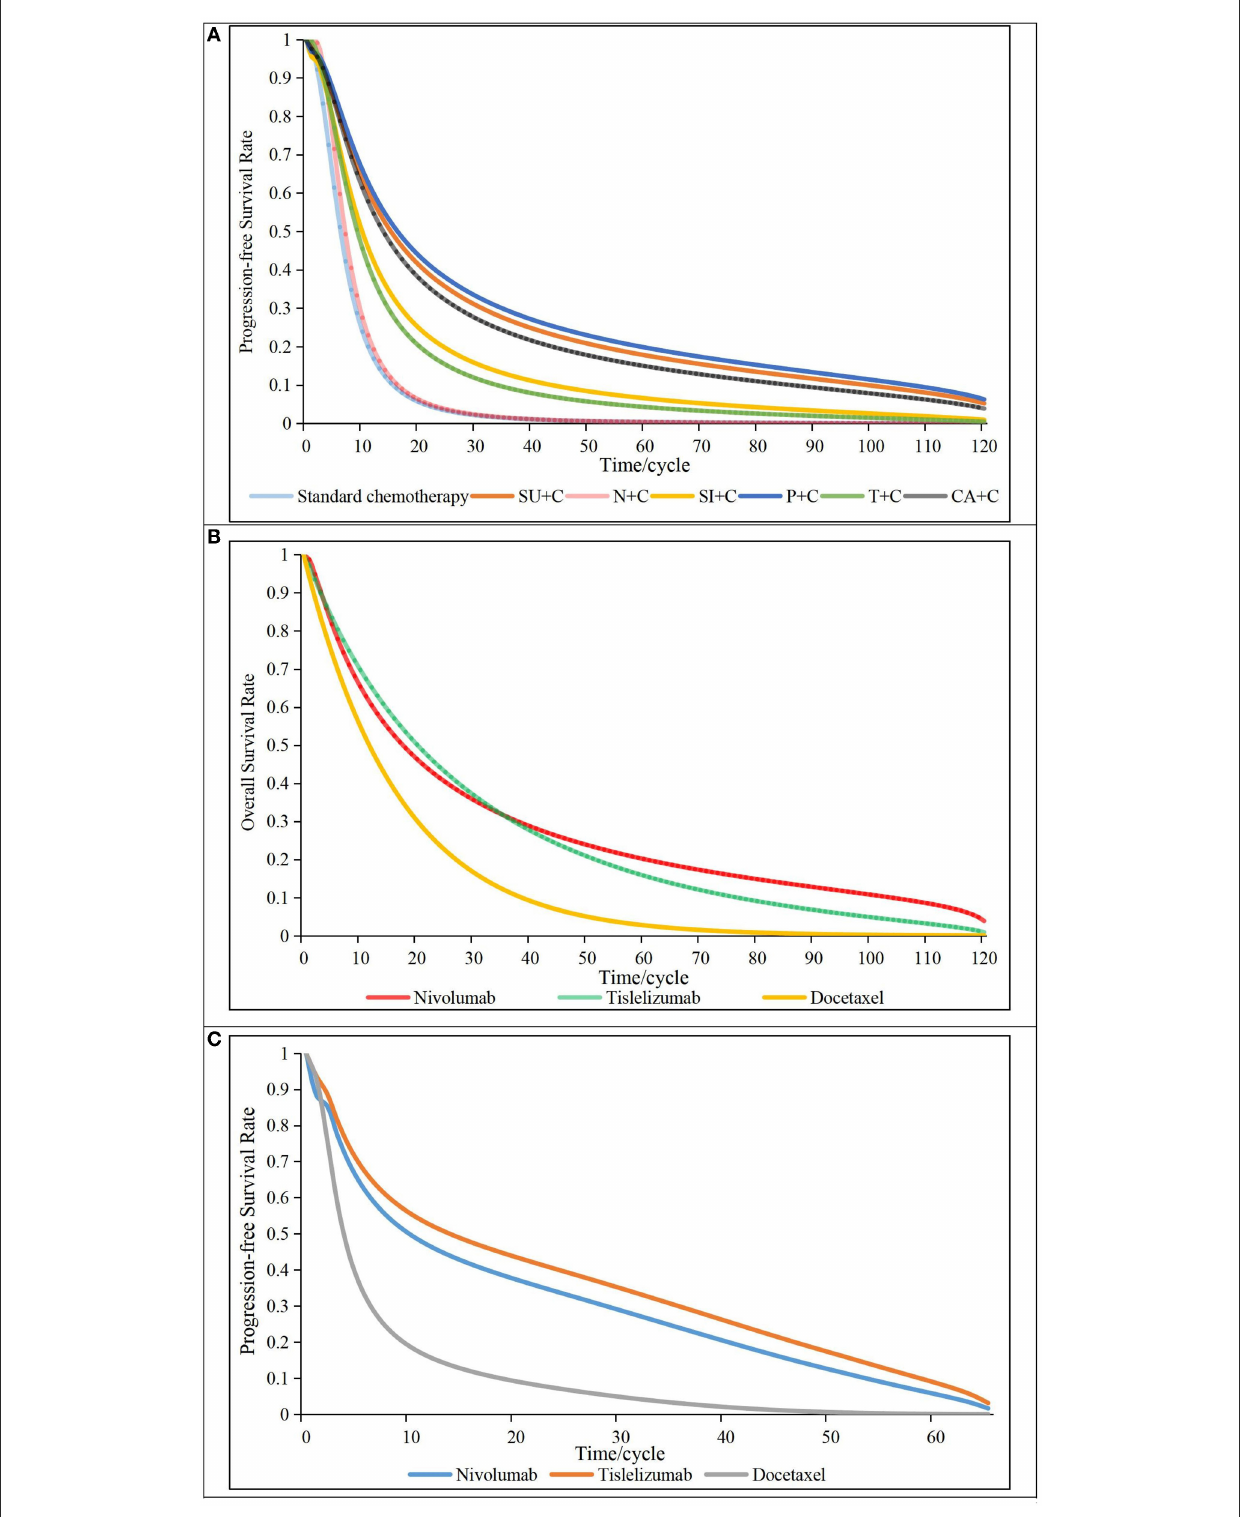
FIGURE2 Survival curves of all first- or second-line treatments. (A) progressive-free survival curves for first-line treatments (above), (B) overall survival curves for second-line treatments (middle), (C) Progressive-free survival curves for second-line treatments (below), N + C, Nedaplatin in combination with standard chemotherapy; SI + C, Sintilimab in combination with standard chemotherapy; P + C, Pembrolizumab in combination with standard chemotherapy; T + C, Tislelizumab in combination with standard chemotherapy; CA + C, Camrelizumab in combination with standard chemotherapy; SU + C, Sugemalimab in combination with standard chemotherapy; cycle, 21